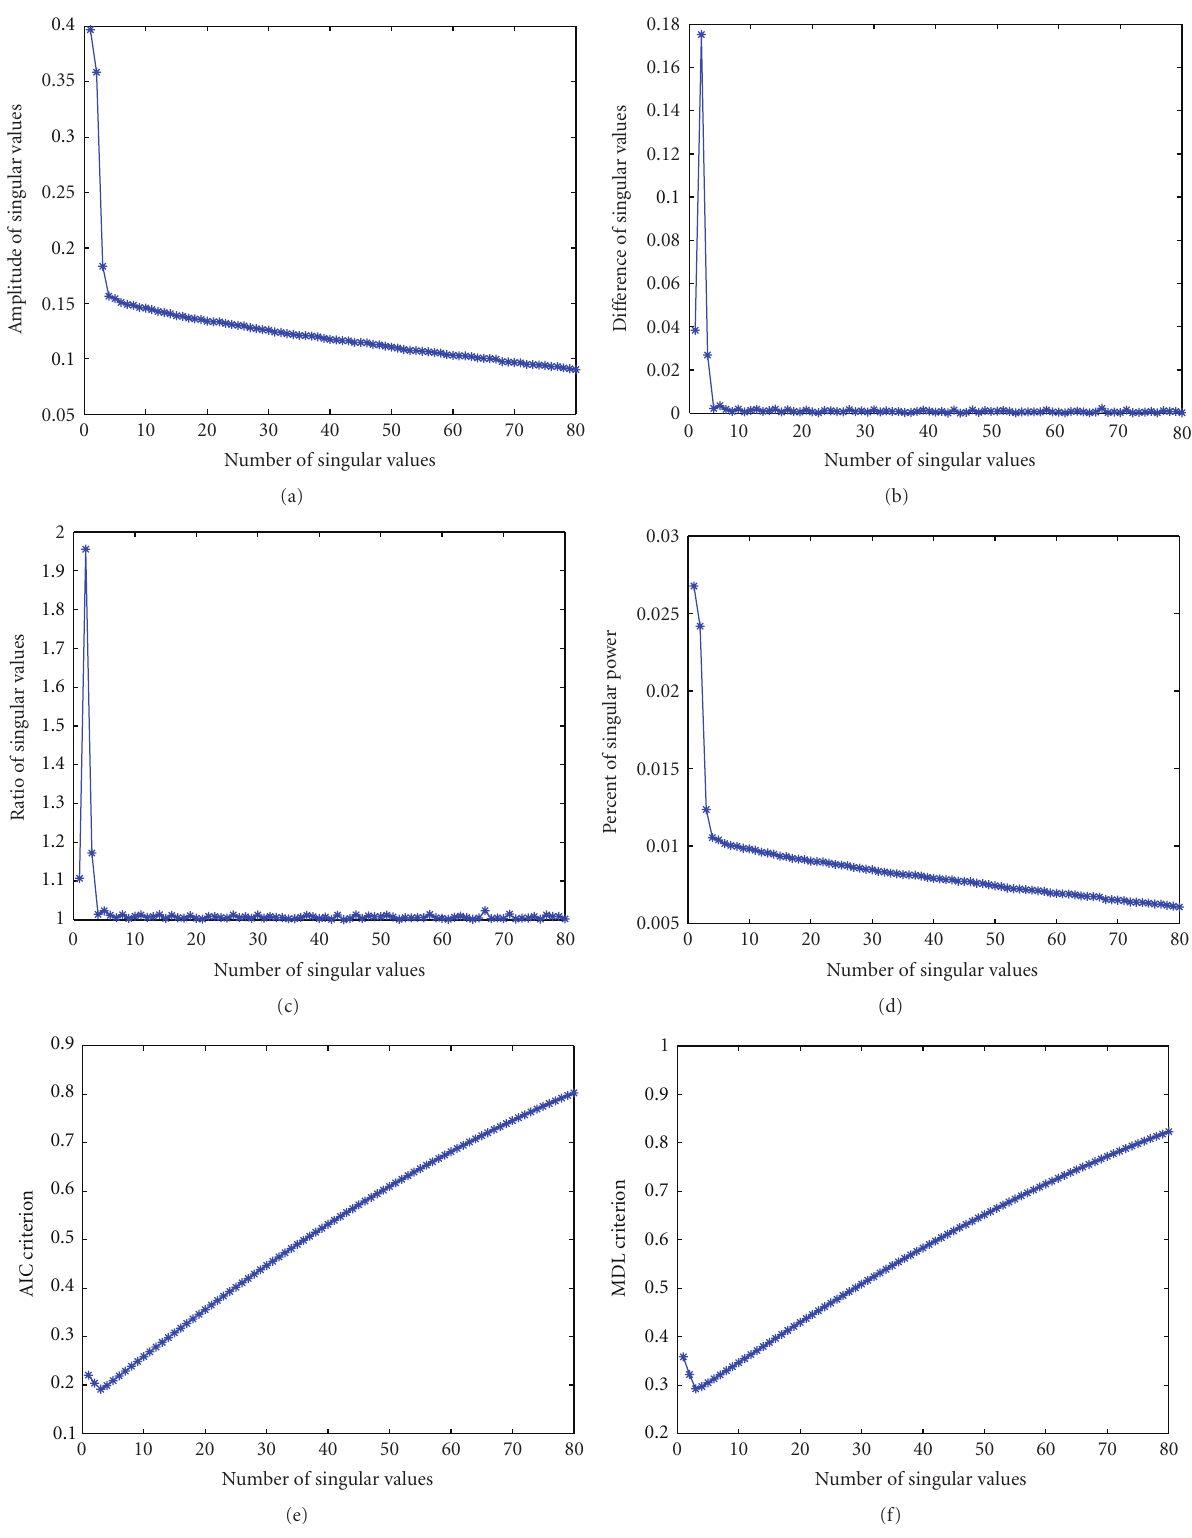
Figure 7: Example 1: Single target (a) amplitude of singular values ( s m ), (b) di ff erence of singular values ( s m − s m +1 ), (c) ratio of singular values ( s m /s m +1 ), (d) power in singular values ( s m / tr[ X ]), (e) AIC function of singular values (10), and (f) MDL function of singular values